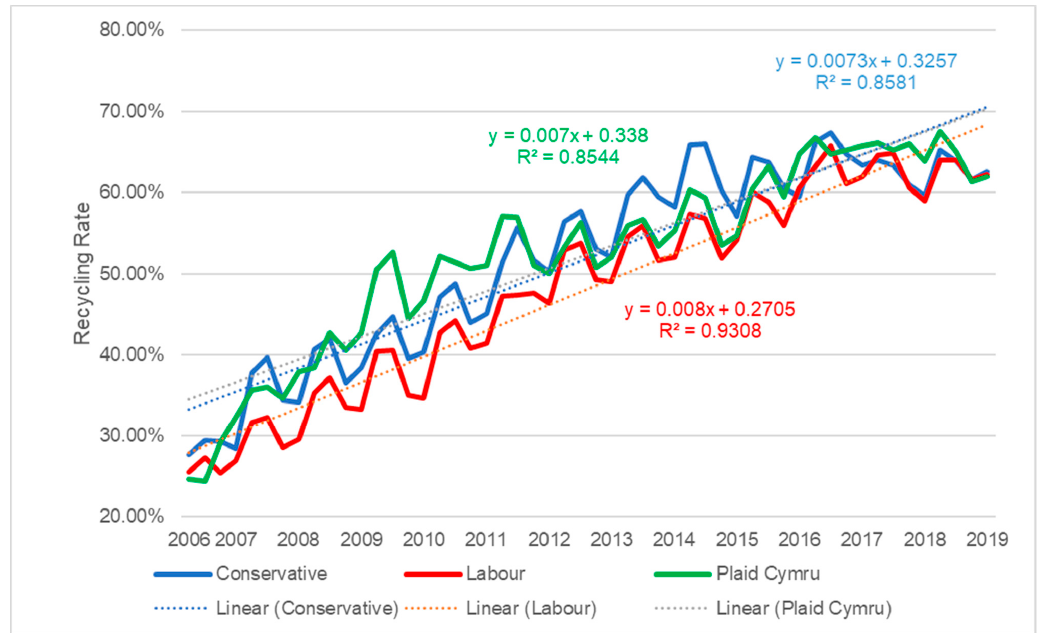
Figure 8. Recycling rate for local authorities (LAs) categorised by majority of election wins per political party. Source: WasteDataFlow.